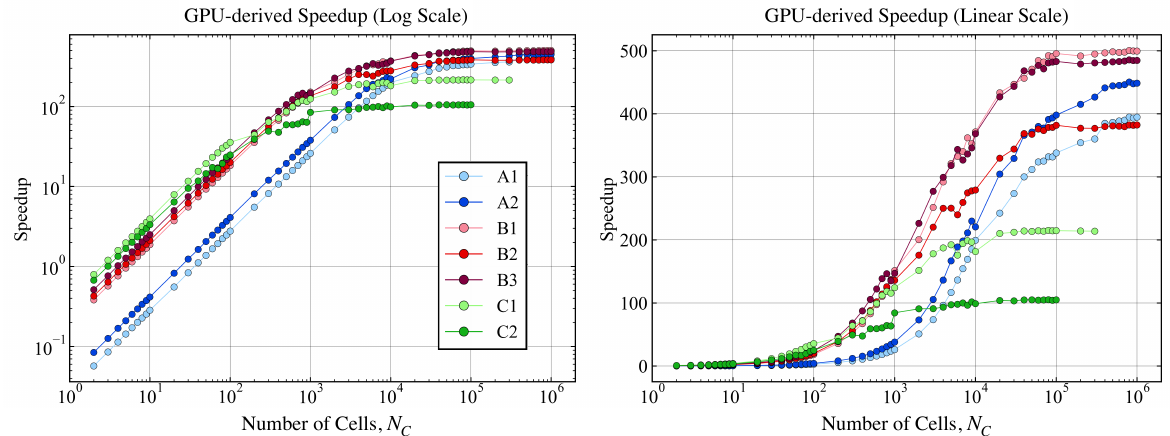
Figure 6. ( Left ) GPU-derived speedup in log-scale with respect to the Cantera-based CPU baseline for all mechanisms listed in Table 1. ( Right ) Same as left but with linear-scale in the y